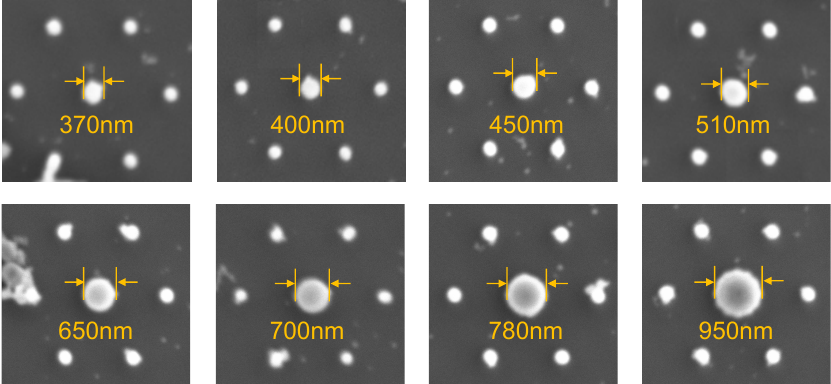
Figure 5. SEM images of pillars structures containing single KTP NPs. All pillars were fabricated by the same exposure dose, except the central one, which was fabricated by the following parameters. Top row : from left to right: P = 6 mW, v = 4 µ m/s; 3 µ m/s; 2 µ m/s; and 1 µ m/s, respectively. Bottom row : from left to right: P = 9 mW, v = 4 µ m/s; 3 µ m/s; 2 µ m/s; and 1 µ m/s, respectively.